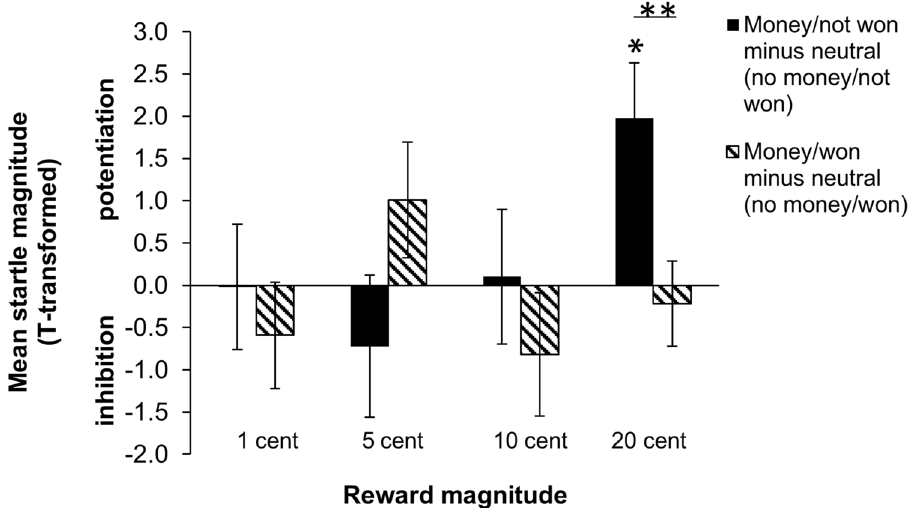
Figure 3. Bar graph showing the interaction between win potential and outcome on startle magnitudes for each reward magnitude group in the feedback phase of the task. Black bars represent the money potential/ not won condition minus the respective neutral condition without potential gain (i.e., no money potential/ not won). Striped bars represent the money potential/ won condition minus the respective neutral condition without potential gain (i.e., no money potential/ won). Specifically for the 20-cents condition startle magnitudes were significantly potentiated when money was at stake but the outcome was ‘not won’ relative to the neutral condition without potential gain. In contrast, startle was not inhibited when the outcome was ‘won’ relative to the neutral condition. Error bars represent ± standard error of the mean. Note that z -scores are transformed to t -scores for illustrative purposes. * p < .05, ** p < .01. Figure S1 in the Supplementary materials presents the t-values for all conditions including the neutral conditions